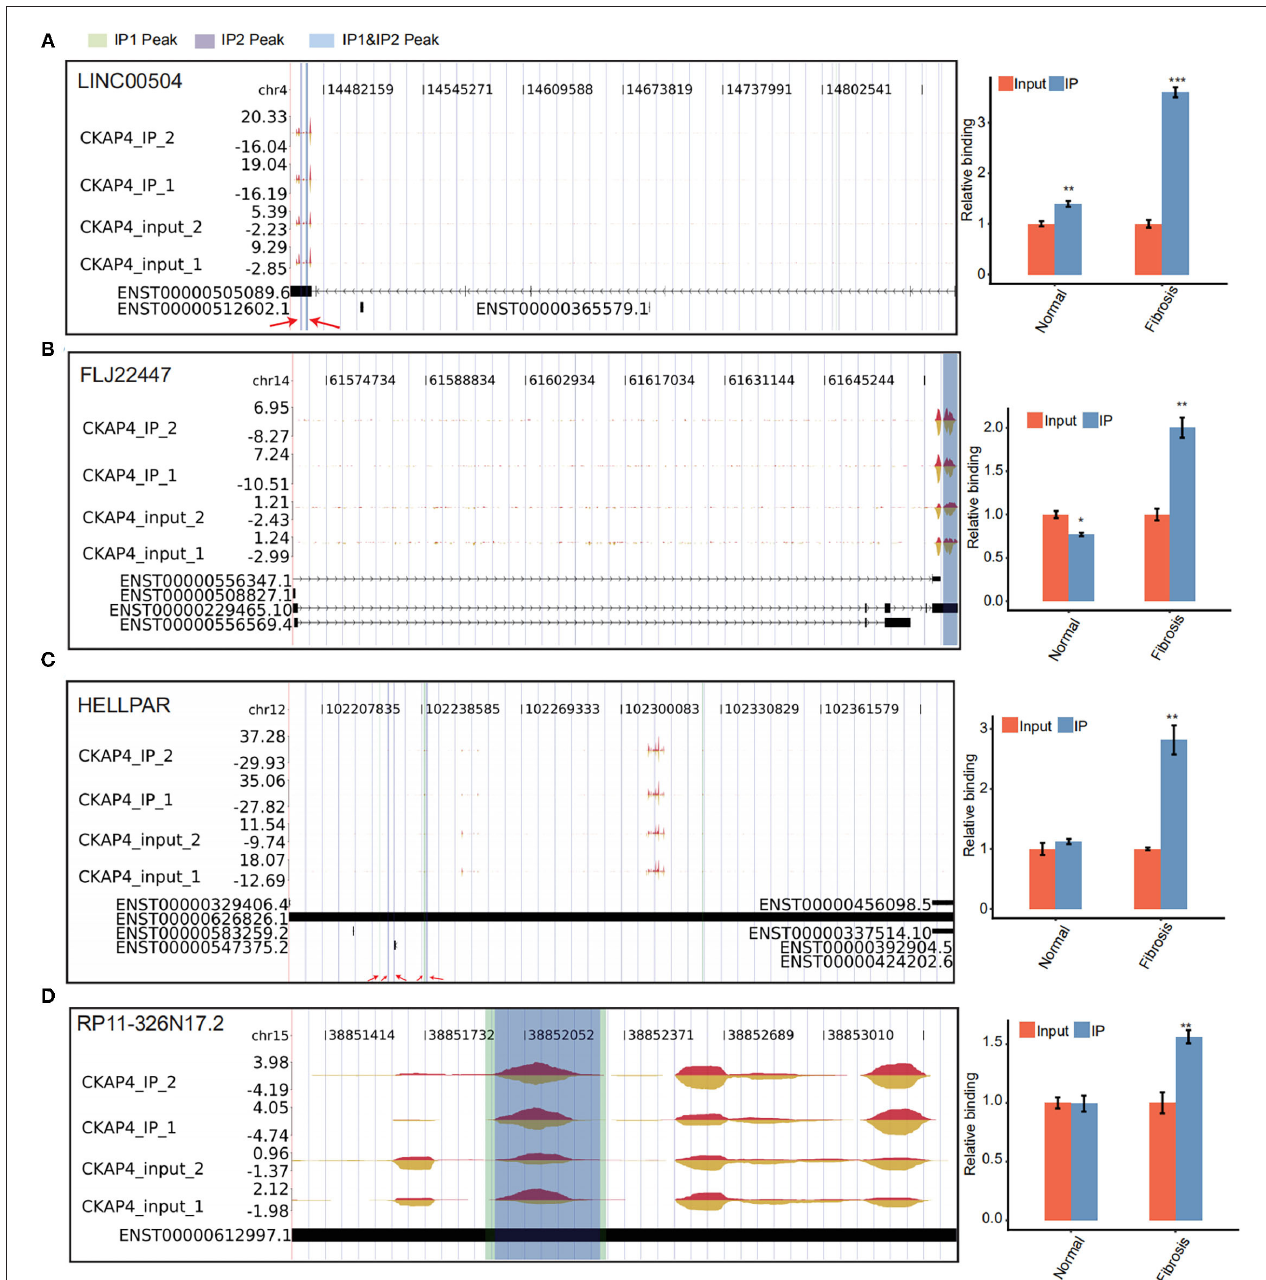
FIGURE 4 | CKAP4 preferentially binds to lncRNAs in remodeling myocardial tissues. (A–D) IGV-sashimi plot showed CKAP4 binding sites across lncRNAs, including LINC00504 (A) , FLJ22447 (B) , HELLPAR (C) and RP11-326N17.2 (D) . RIP-qPCR validated the binding reliability of CKAP4 with these lncRNAs (right). The asterisk (*) indicates * P < 0.05, ** P < 0.01, *** P <